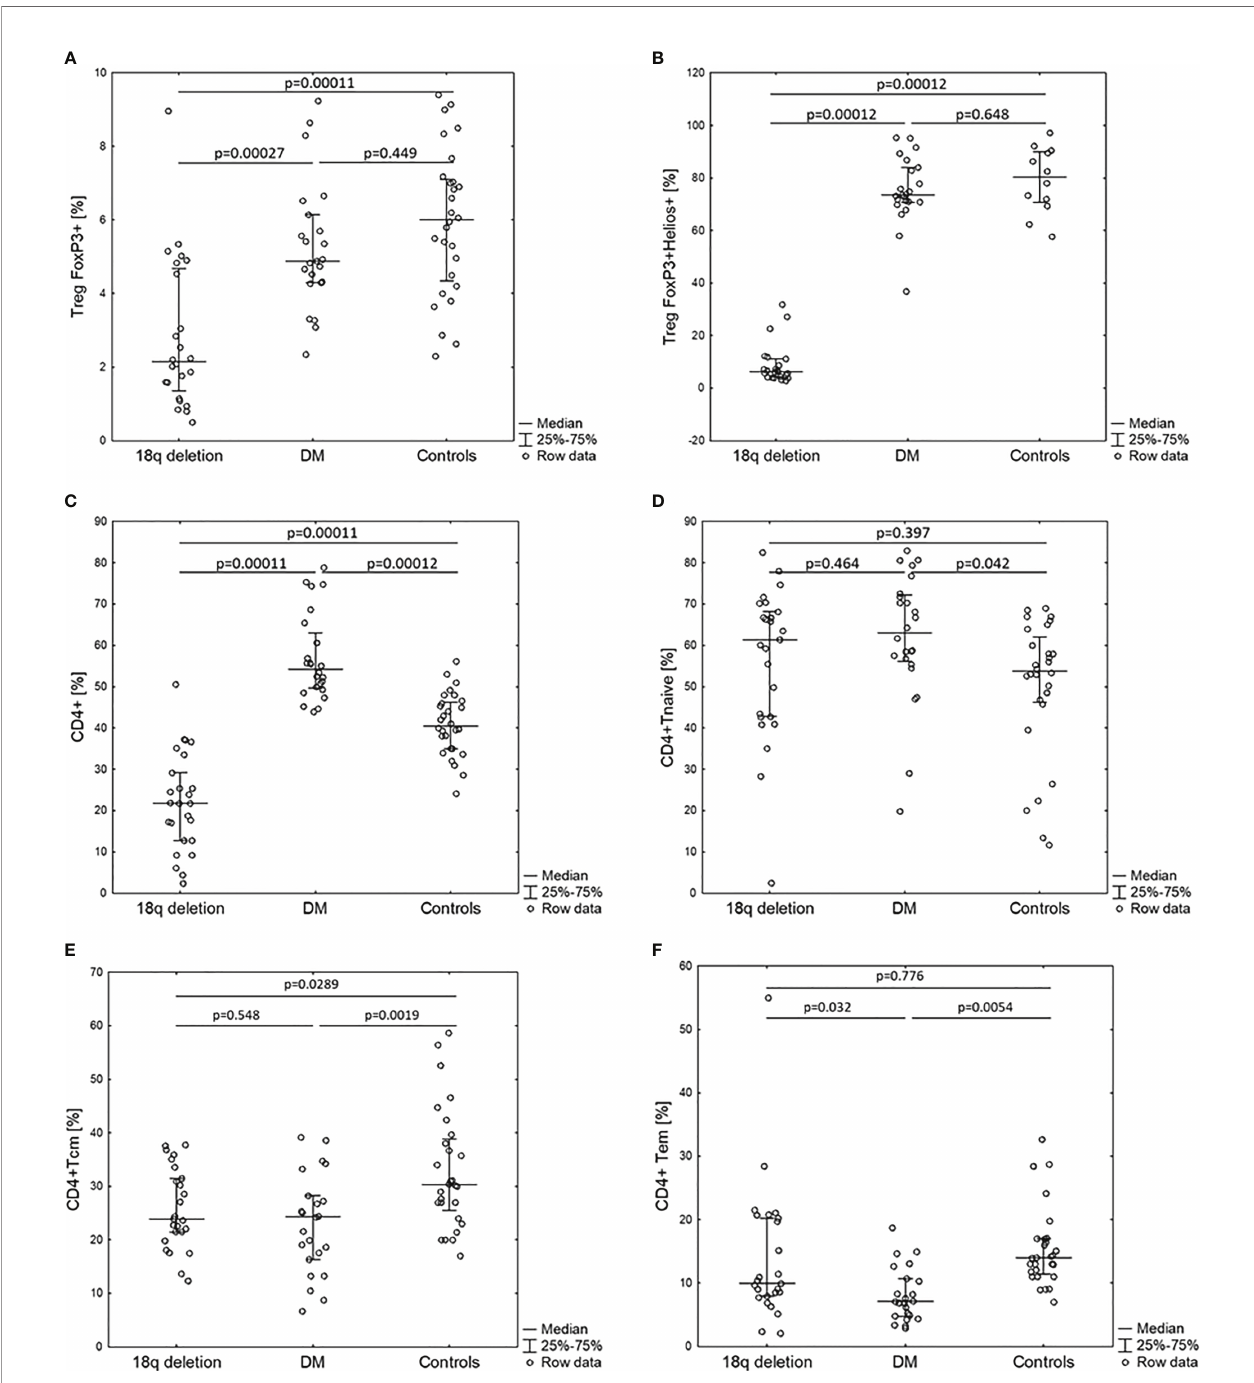
FIGURE 2 | Percentage of CD4+ lymphocyte subpopulations of patients with 18q deletion syndrome, type 1 diabetes (DM), and healthy controls. (A) CD4+CD25 +FOXP3+, (B) CD4+CD25+FOXP3+Helios+, (C) CD4+, (D) CD4+naïve, (E) CD4+T central memory, (F) CD4+T effective